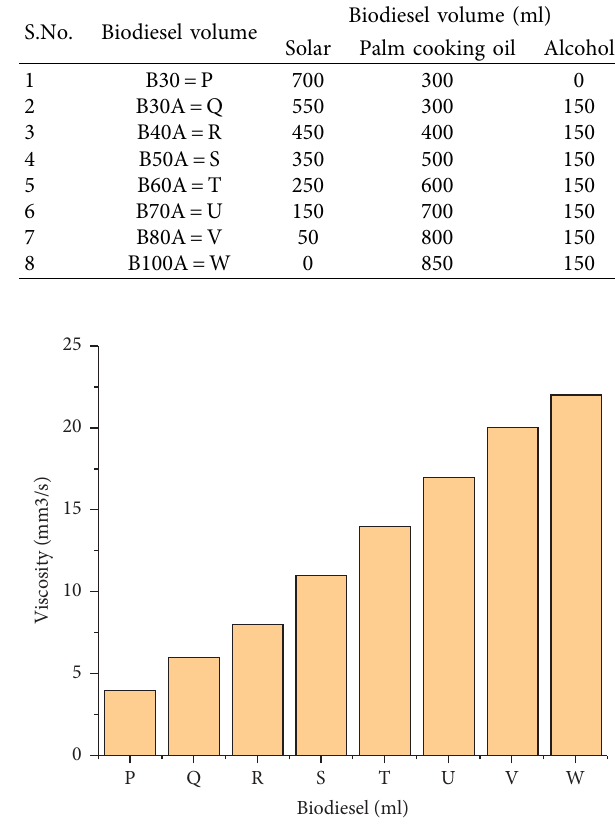
Figure 1: Te viscosity of biodiesel with varying